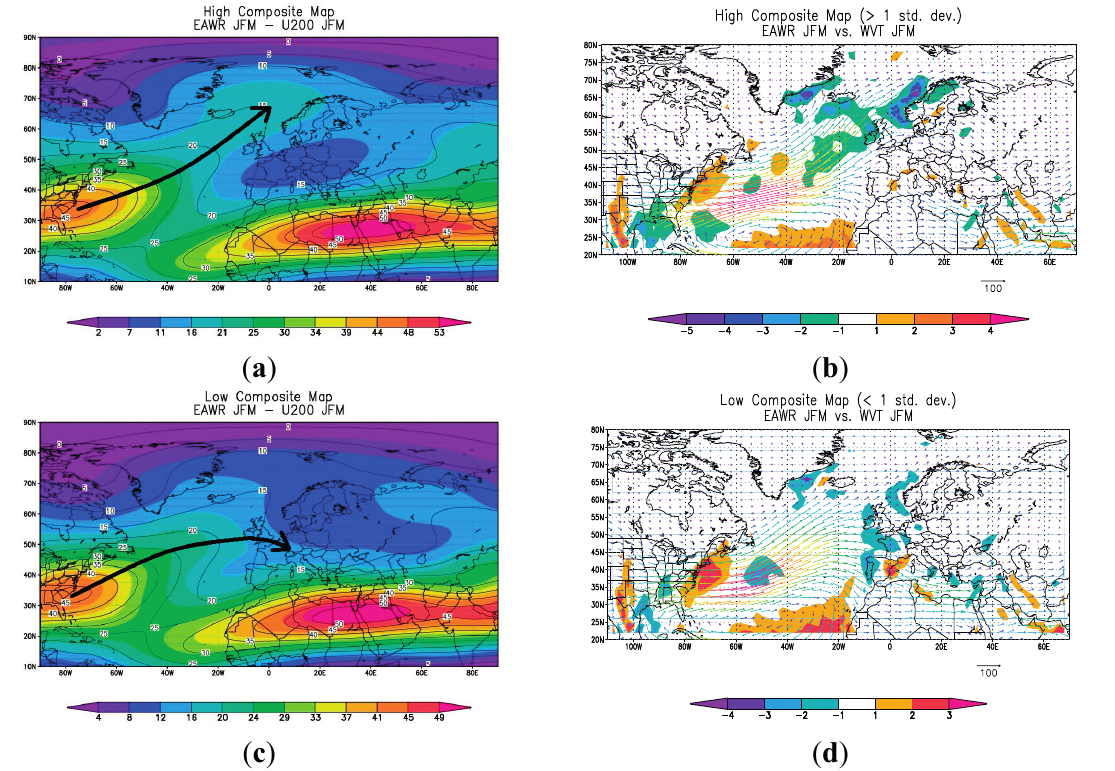
Figure 6. The composite maps between the normalized time series of JFM EAWR and JFM zonal component of mean wind at 200 hPa for ( a ) High (JFM EAWR > 1 std. dev.) and ( c ) Low (JFM EAWR < − 1 std. dev.) The composite maps between the normalized time series of JFM AO and JFM vertically integrated water vapor transport for ( b ) High (JFM EAWR > 1 std. dev.) and ( d ) Low (JFM EAWR < − 1 std. dev.) For (a,c) Climatological means are shown as contour lines. Units are m/s; For (b,d): The shaded areas indicate the distribution of the horizontal divergence of the total water vapor transport (units 10 − 6 kg/m 2